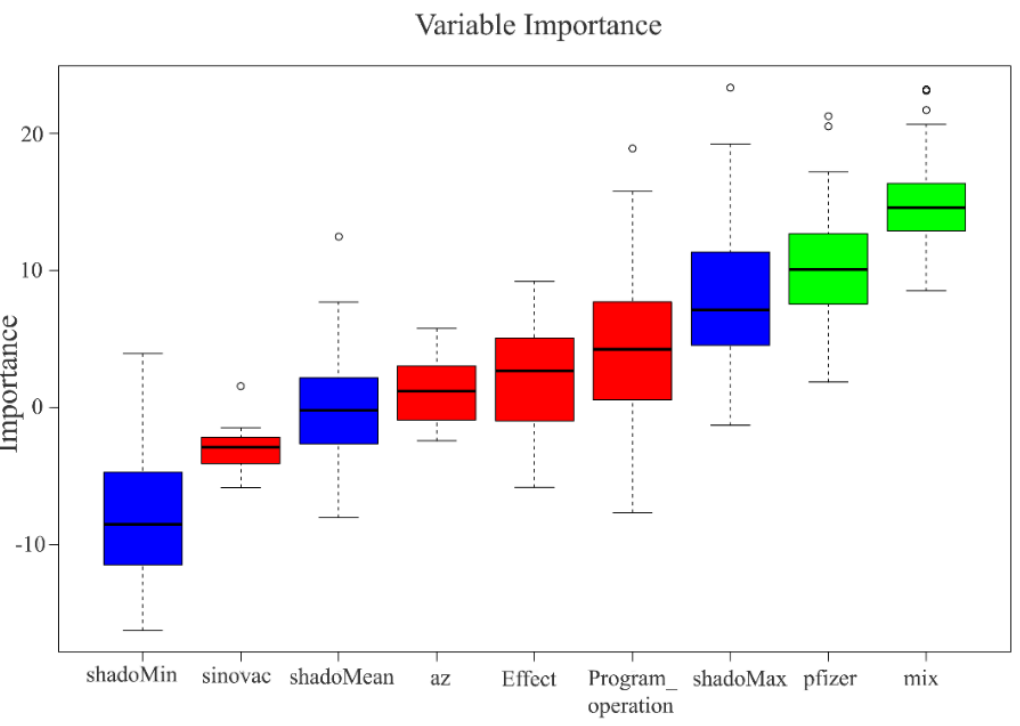
Figure 8. Boruta result plot for six possible determinants. Blue boxplots represent the minimal, average, and maximum Z-score of a shadow attribute. Red and green boxplots represent Z-scores of respectively rejected and confirmed attributes.